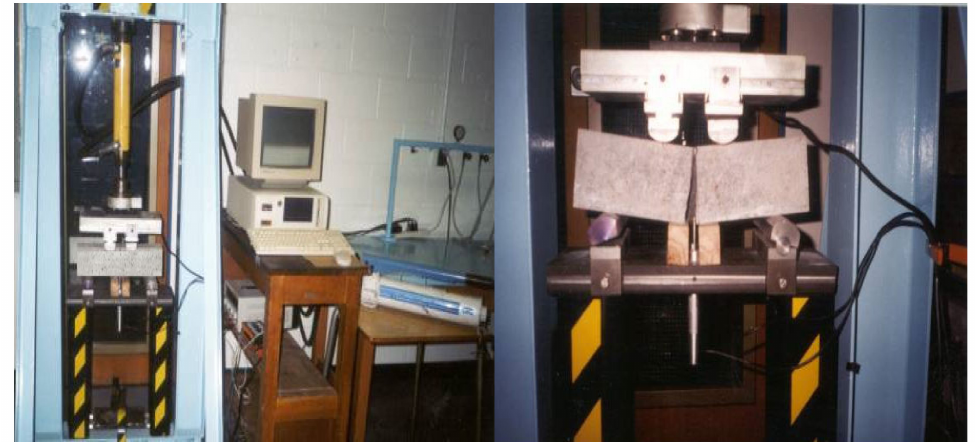
Figure 4. Flexure testing of mortar composite using prism or beam